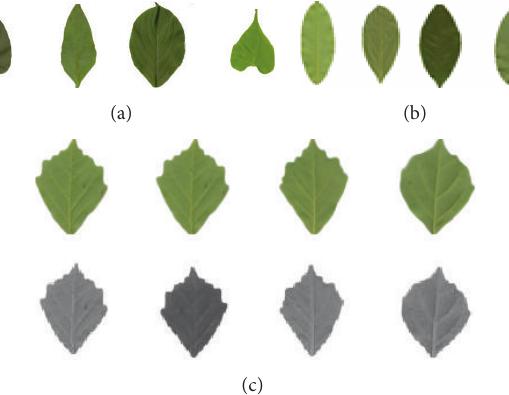
Figure 2: Typical leaves of the leaf database